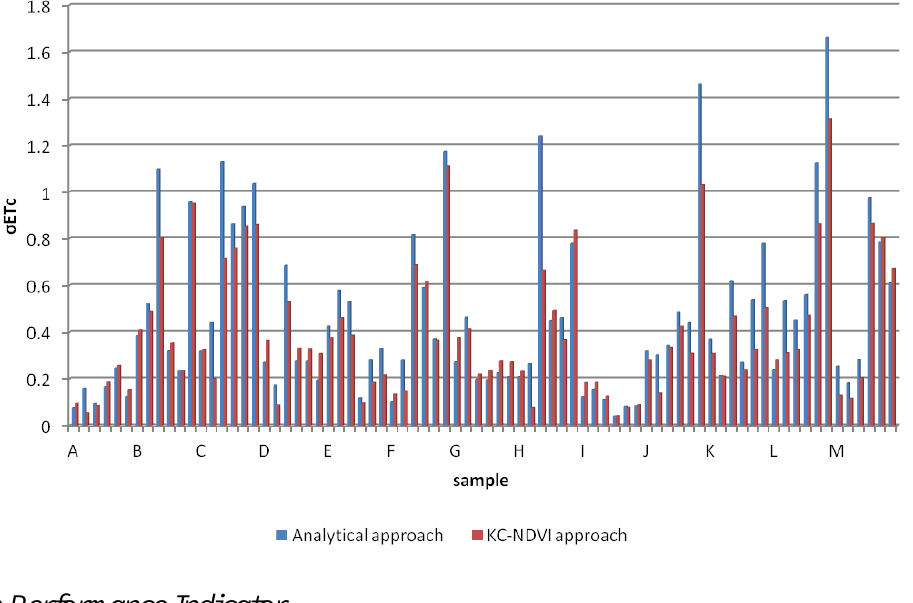
Figure 16. Statistical analysis of ETc standard deviation in 10 samples (3 ×